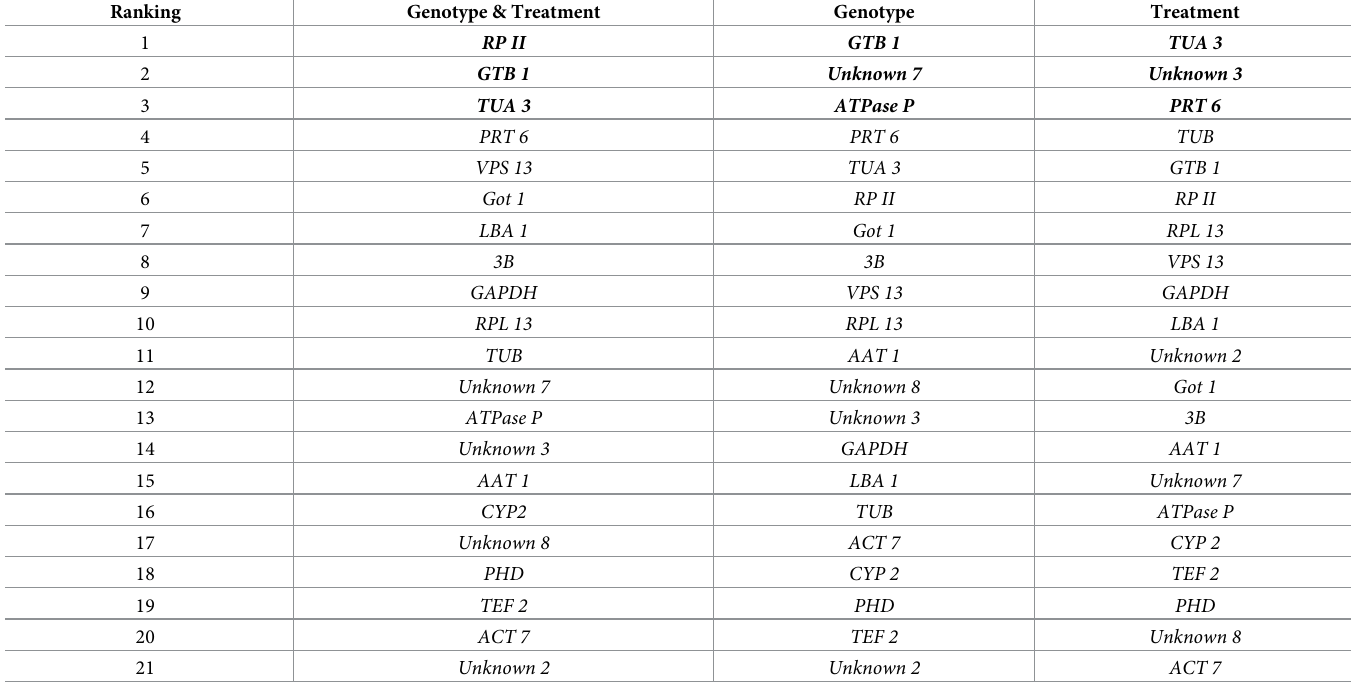
Table 3. Ranking of putative housekeeping genes according to NormFinder.